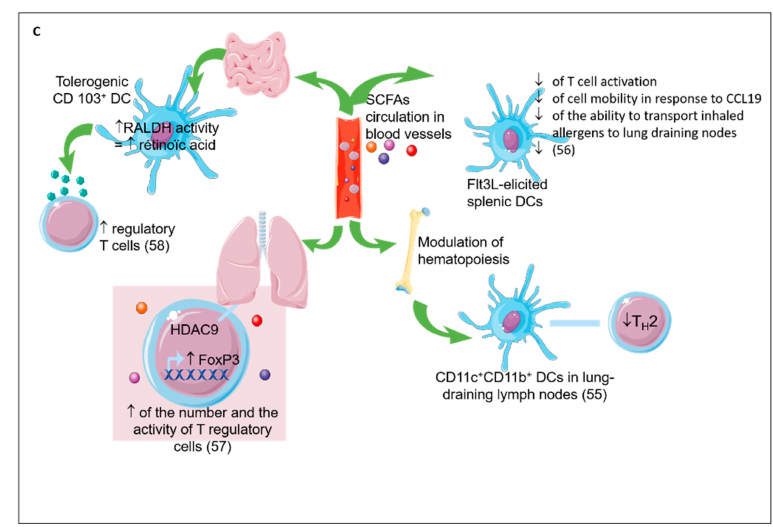
Figure 3. Indirect effects of prebiotics. ( A ) The general mechanisms of SCFAs. The SCFAs are metabolites derived from the fermentation of prebiotics by the microbiota. They are consumed by the microbiota or released into the biological systems (blood, gut, lung, placenta). They can interact with the cells by three mechanisms. In the first mechanism, the GPRs which are receptors coupled to signaling pathways (AMP-activated protein kinase (AMP-K), mammalian target of rapamycin (mTOR), signal transducer and activator of transcription 3 (STAT3), mitogen-activated protein kinases (MAPKs), nuclear factor kappa-light-chain-enhancer of activated B cells (NF- κ B)) are involved. The second mechanisms correspond to the diffusion channels (solute carrier family 16 member 1 (Slc) 16a1 and 5a8) that allow the SCFAs transport directly to cytoplasm and their potential interactions with pathways. By these two mechanisms, thesignalingcascadeisactivatedandcaninfluencethetranscriptionofgenesbyacetylationanddeacetylation respectively via the histone acetyltransferases (HAT) and the histone deacetylases (HDAC) enzymes (epigenetic mechanisms). In the last mechanisms, there is a passive diffusion of SCFAs able to modulate directly enzymes (HDAC, HAT) involved in epigenetic processes. The modulation of genes expression by acetylation and deacetylation will have different consequences such as a modification of metabolism, cell cycle or microbial activity described in Figure 3B,C. ( B ) The specific impact of SCFAs on epithelial cells. SCFAs (butyrate, propionate) can interact with the G-protein coupled receptor (GPR)43 receptor and activates the mTOR / STAT3 pathway allowing the modulation of genes to increase the expression of antimicrobial peptides such as regenerating islet-derived protein 3 gamma (RegIII γ ) and β -defensins. SCFAs can directly increase the epithelial barrier function by stimulating O2 metabolism in intestinal epithelial cell lines. This mechanism results in the stabilization of the transcription factor hypoxia-inducible factor (HIF-1). SCFAs interact also with the GPR 41 (acetate, propionate) and GPR43 receptors to activate the extracellular signal-regulated kinases (ERK) 1 / 2 and MAPK signaling pathway. In this way, epithelial cells produce inflammatory chemokines and cytokines during the immune response to protect the organism against aggressions or infections. The consumption of SCFA also increases the secretion of the antimicrobial peptide by epithelial cells. ( C ) The specific impact of SCFAs on IS. SCFAs can be found in the bloodstream. They can interact with different immune cell subtypes. In a first step they can modify the hematopoeisis of dendritic cells (DC) precursors in the bone marrow and induce CD11c + CD11b + DCs in lung-draining lymph nodes. The cells CD11c + CD11b + DC have a lower capacity to activate the Th2 cell which results in the reduction of allergic asthma. SCFAs are also able to modify in vitro the functionality of FMS-like tyrosine kinase 3 ligand (Flt3L)-elicited splenic DCs: a lower ability to activate T cell and to transport antigen to the lymph node and a lower expression of chemokine (C-C motif) ligand 19 (CCL19) on their surface decreasing their ability to move in different sites. In the lungs SCFAs are able to inhibit the enzyme HDAC9 resulting in an increase of the forkhead box P3 (FoxP3) transcription factor and then an increase of the number and the activity of Treg. In the intestine the increase of retinoic acid-synthesizing (RALDH) enzyme activity during the consumption of SCFA, allows the conversion of vitamin A to the retinoic acid in tolerogenic DC CD103 + . Then, the retinoic acid acts directly on T cells and induces their differentiation into